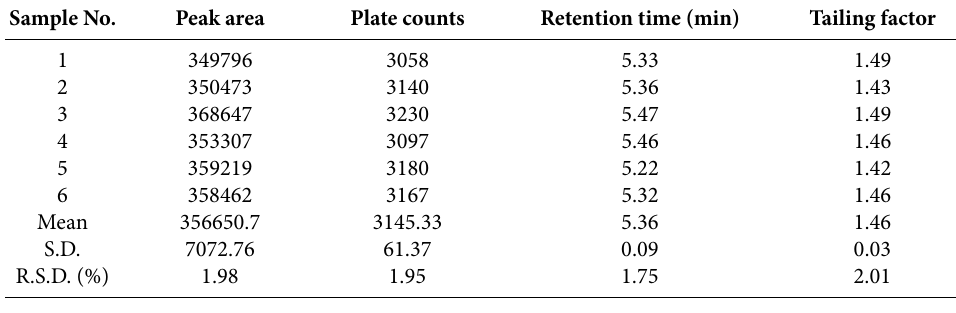
Table 1. System suitability of the developed method Sample No.